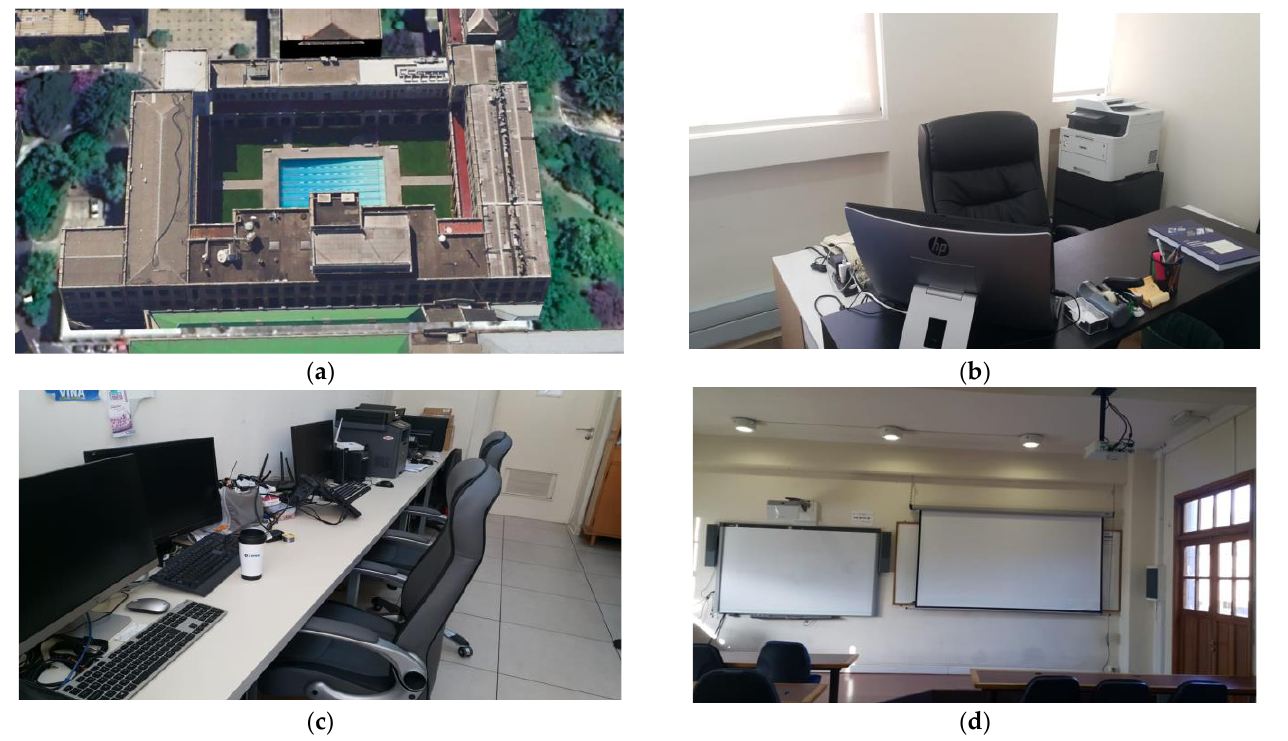
Figure 4. Locations of different implantation scenarios: ( a ) Engineering building B; ( b ) Office B-349; ( c ) Laboratory B-110; and ( d ) Classroom B-213. Table 2. List of appliances.